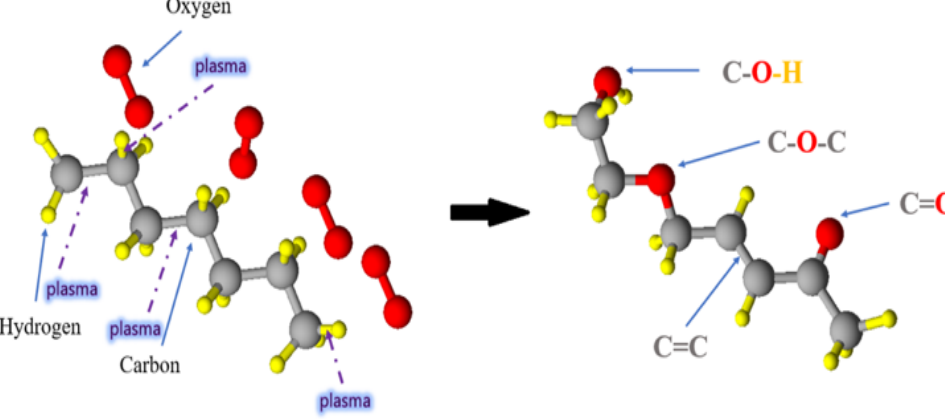
Figure 6. ( a ) FTIR spectra of LDPE at different V a ( b ) FTIR spectra of LDPE at different frequencies.